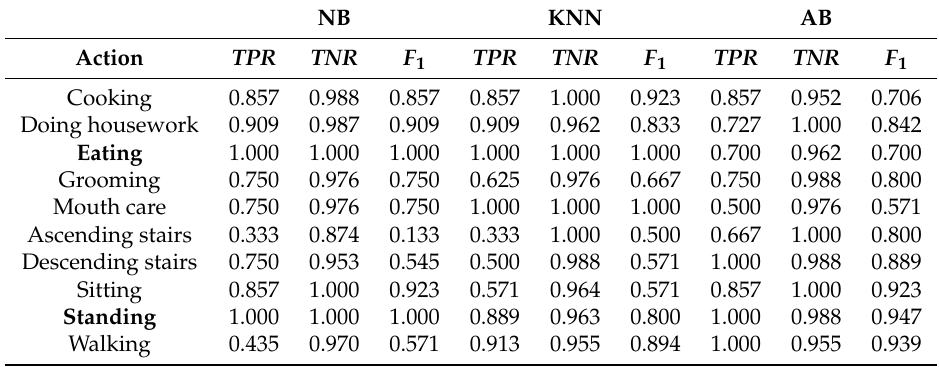
Table 2. Classification results for each action using High-level features extracted with the static approach. KNN: K-nearest neighbours, NB: Naive Bayes, and AB: AdaBoost inference algorithms. NB KNN AB